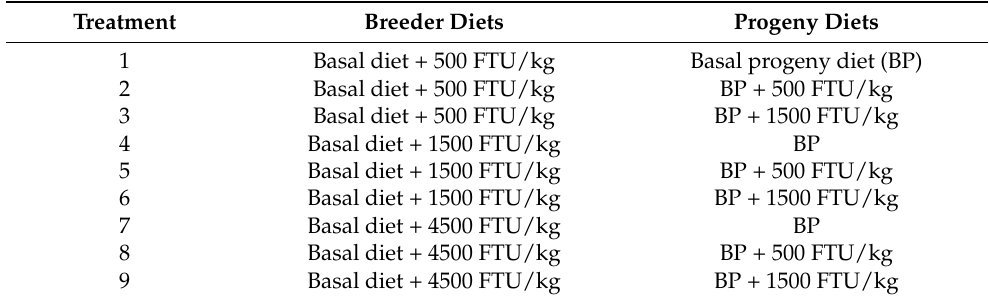
Table 3. Progeny experiment design: completely randomized 3 × 3 factorial design.